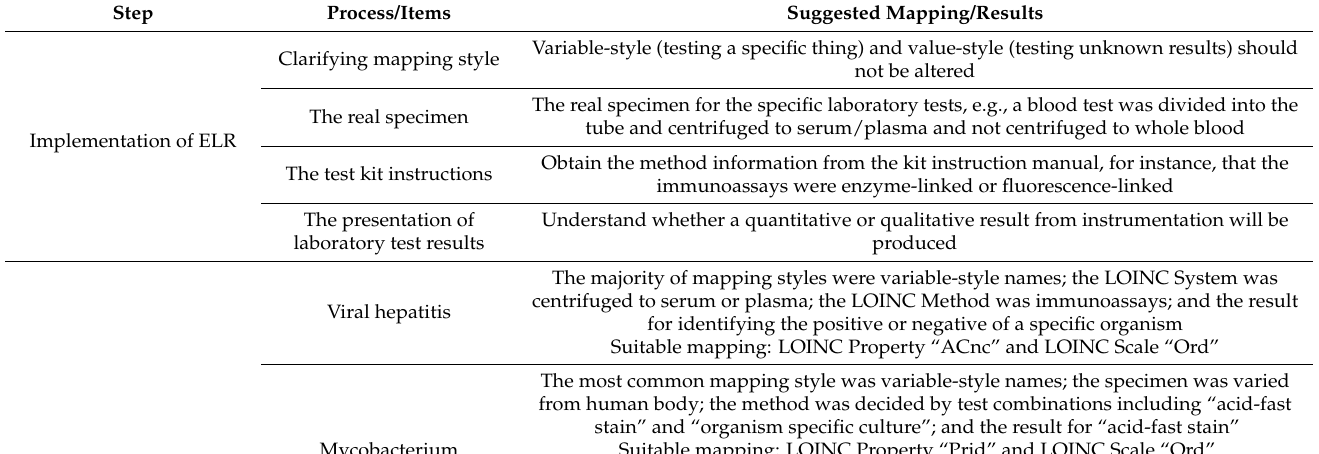
Table 4. Suggestions for LOINC mapping